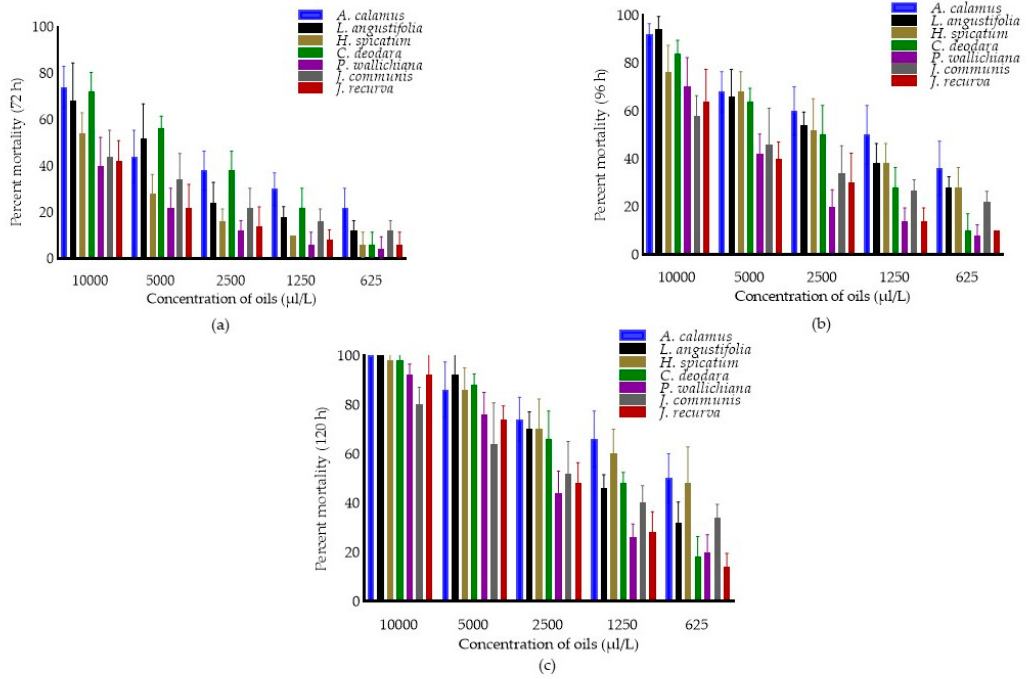
Figure 1. Percent mortality of essential oils in C. maculatus after 72 h ( a ) 96 h ( b ) and 120 h ( c ). Bars represent the standard deviation ( ± SD) of five replications. Means ± SD in the error bars differs significantly by Tukey’s HSD ( p < 0.0001). Table 3. Toxicity of different essential oils and their combinations against C. chinensis